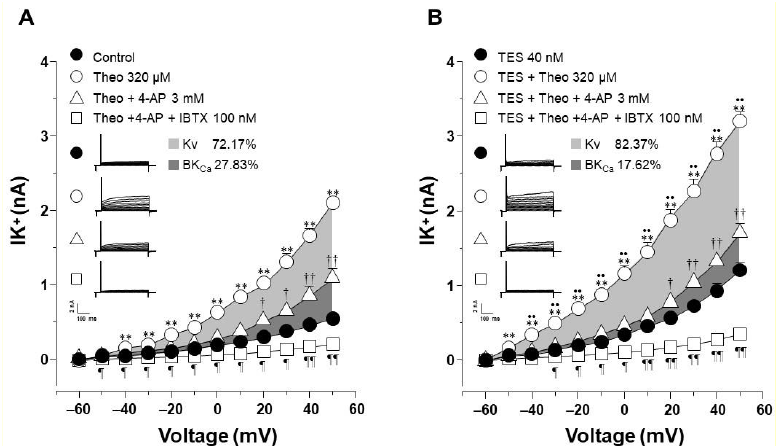
Figure 5. Voltage-dependent delayed rectifier K + (K V ) channels are involved in the theophylline-induced IK + enhancement after testosterone (TES) chronic incubation in guinea pig tracheal smooth muscle cells. ( A ) Perfusion of theophylline (Theo) 320 µ M to single myocytes resulted in a significant increase in IK + from -40 mV ahead, which was partially reduced by 4-aminopyridine (4-AP, 3 mM),